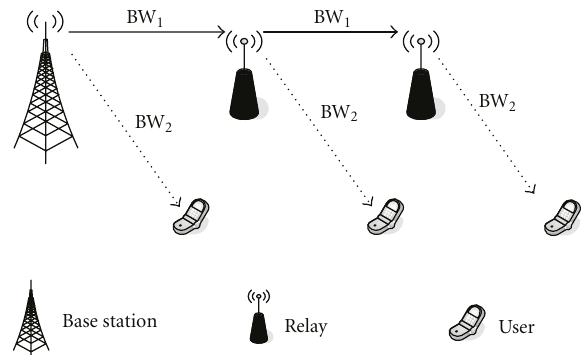
Figure 1: The proposed system model for the scalable self- configuring